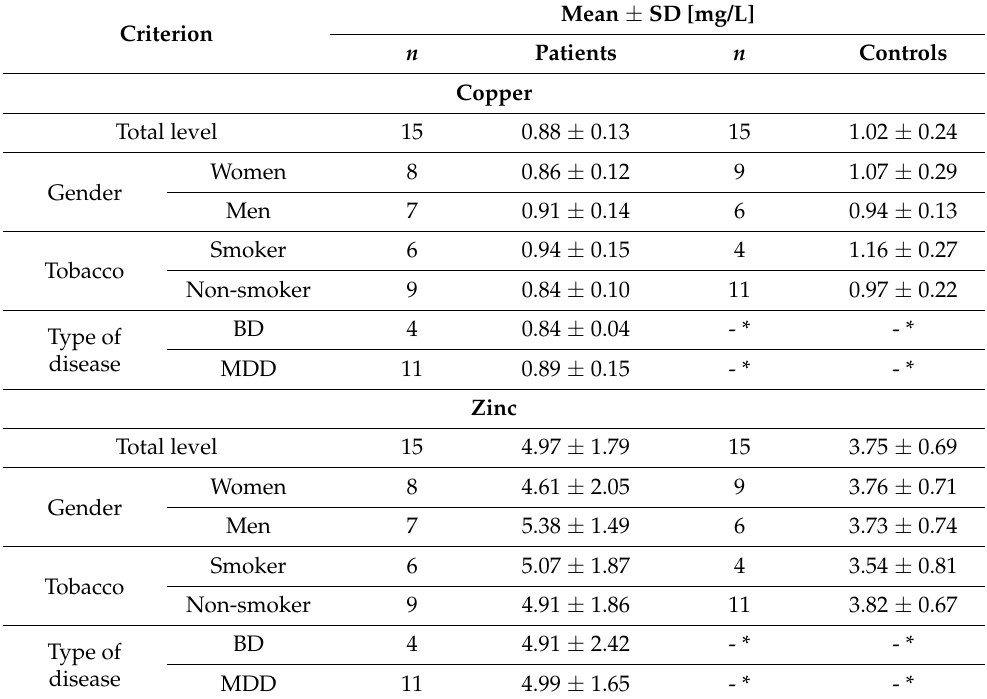
Table 1. Zn and Cu values in blood serum [mg/L] in control and patient groups. The results were analyzed according to criteria: gender, smoking, type of disease. Results are presented as mean ± standard deviation. Mean ± SD [mg/L] Criterion n Patients n